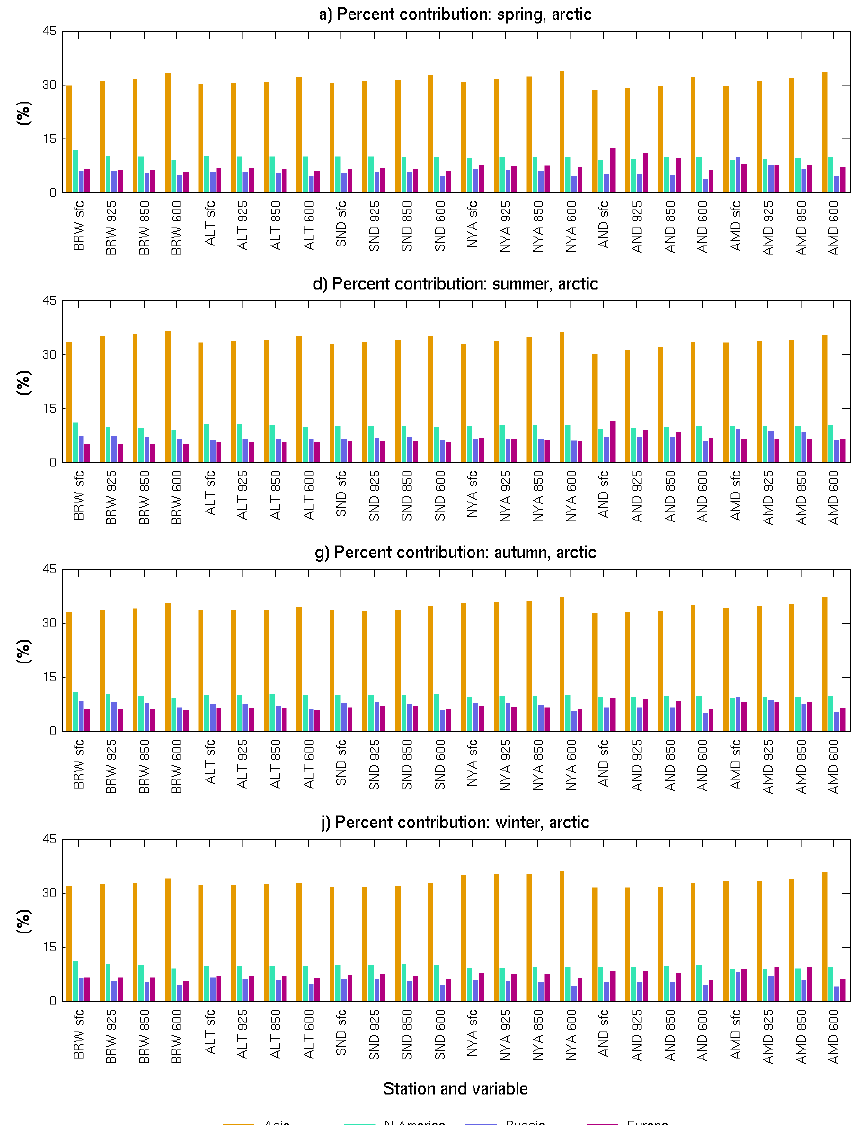
Fig. 4. Shown for the indicated station, level and season is each source region’s percent contribution to the base run’s concentrations. Table 1 identifies whether GEM or TGM contributions are calculated at the surface. GEM contributions are calculated at all stations at 925, 850 and 600hPa. Stations from each station group are arranged from west to